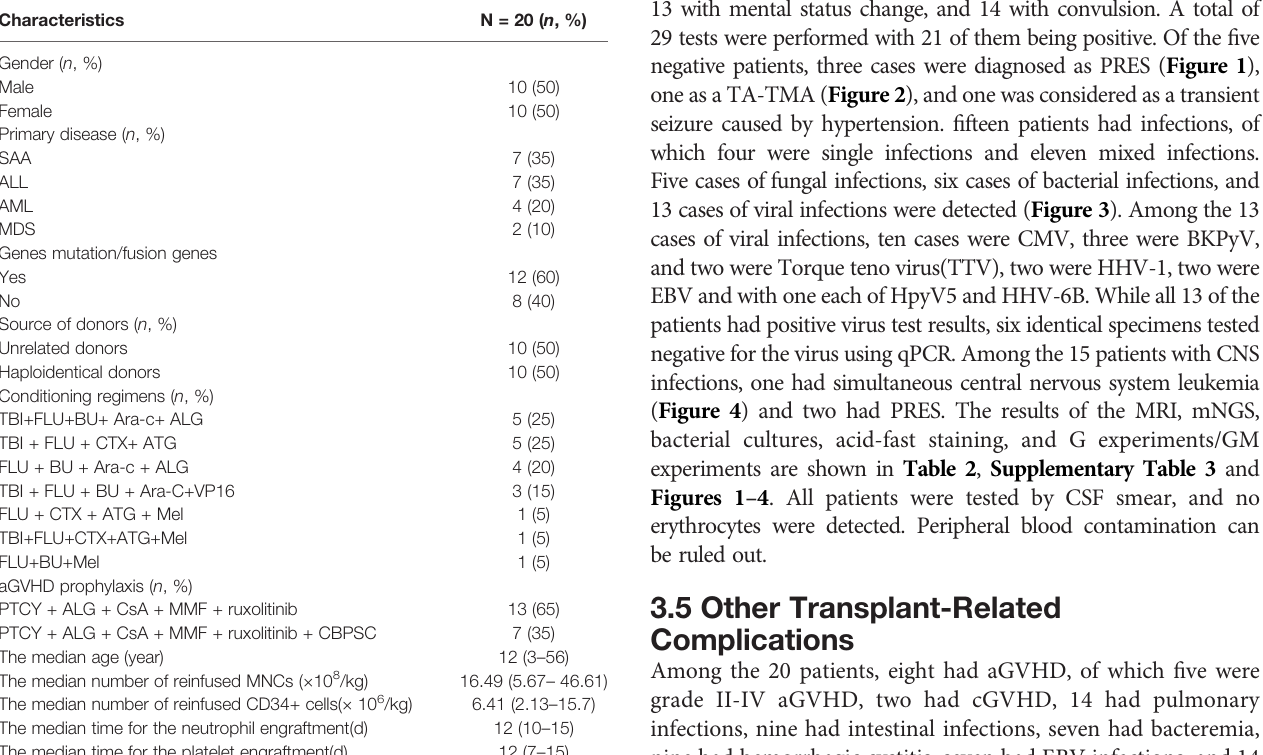
TABLE 1 | Characteristics of patients (N =